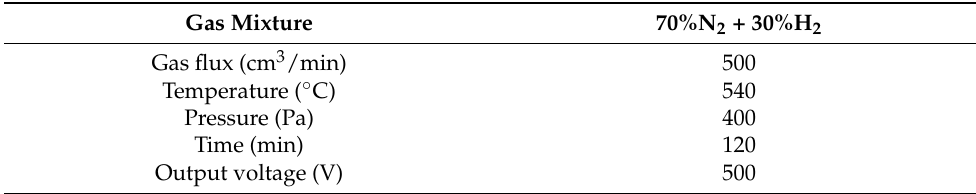
Table 4. Parameters used in the plasma nitriding